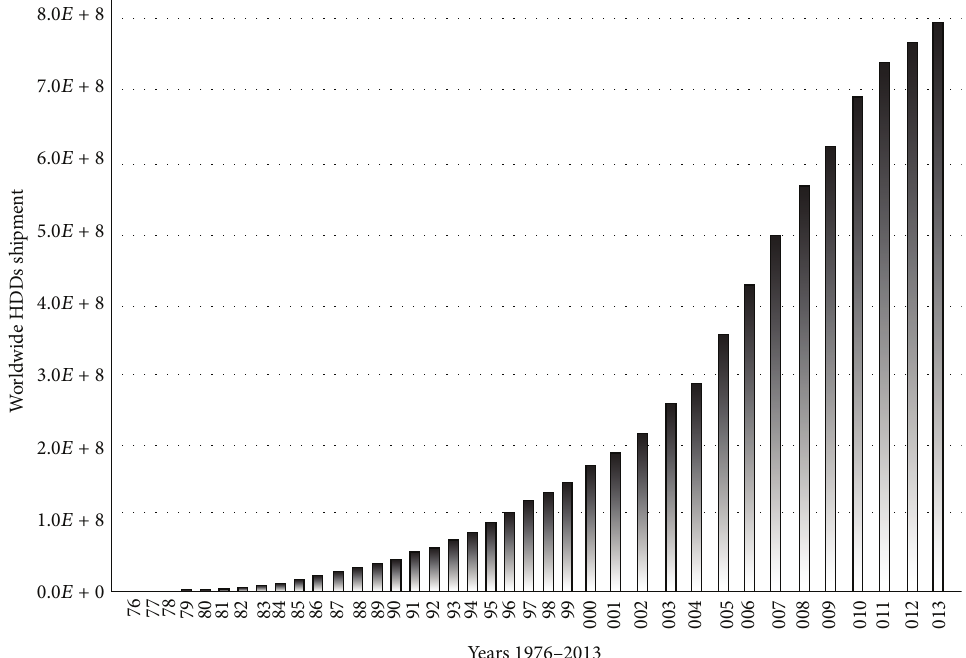
Figure 2: Worldwide shipment of HDDs from 1976 to